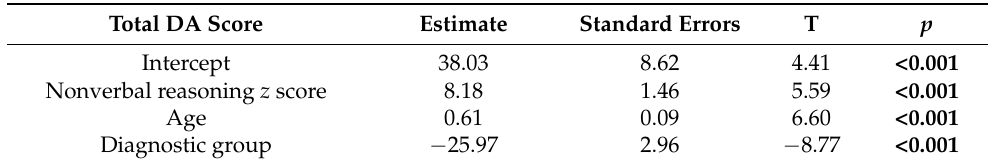
Table 5. Linear regression of total DA score using age, nonverbal reasoning z score, and diagnostic group as independent variables.